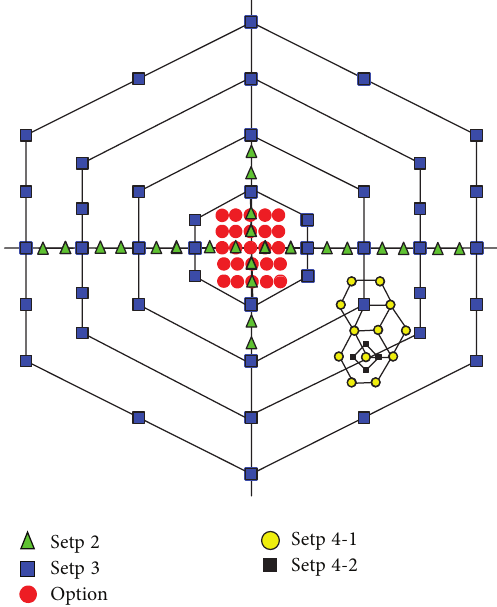
Figure 2: Search process and search pattern of